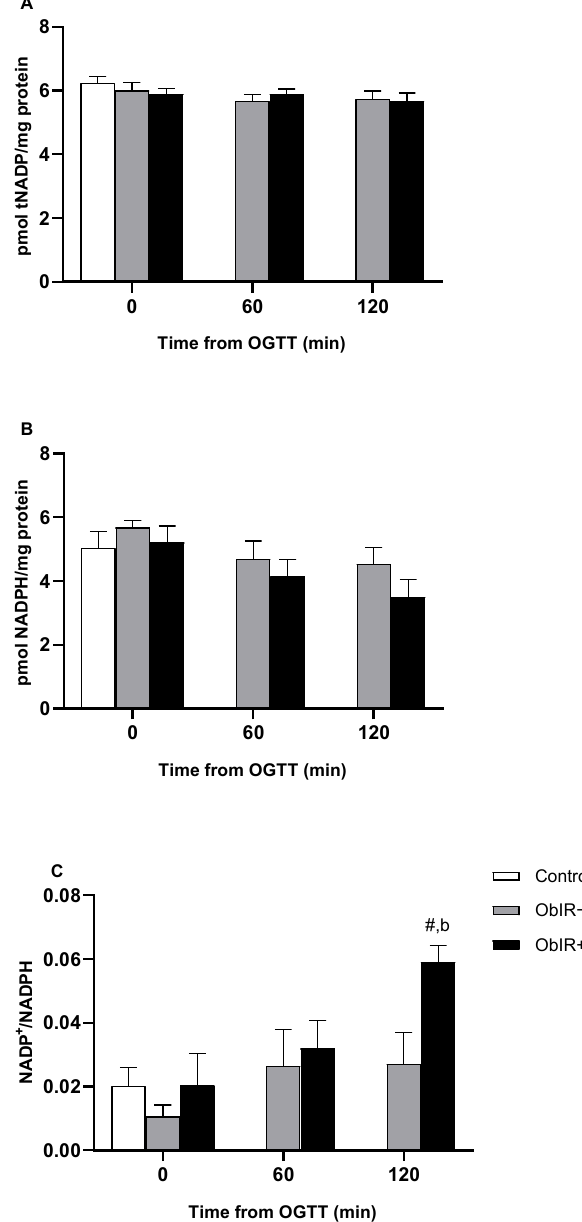
Figure 3. NADPH availability in RBCs of controls and obese children. Total NADP (tNADP) ( A ) and NADPH ( B ) were measured in RBCs at baseline and along OGTT. NADP + data were extrapolated from both total NADP and NADPH and used to calculate the NADP + /NADPH ratio ( C ). White bars represent the control group, grey bars represent ObIR − group, and black bars represent ObIR+ group. Values are means ± SEM. p < 0.05 was considered for statistical significance. (b) shows significant differences relative to ObIR − , and ( # ) shows intragroup differences along the